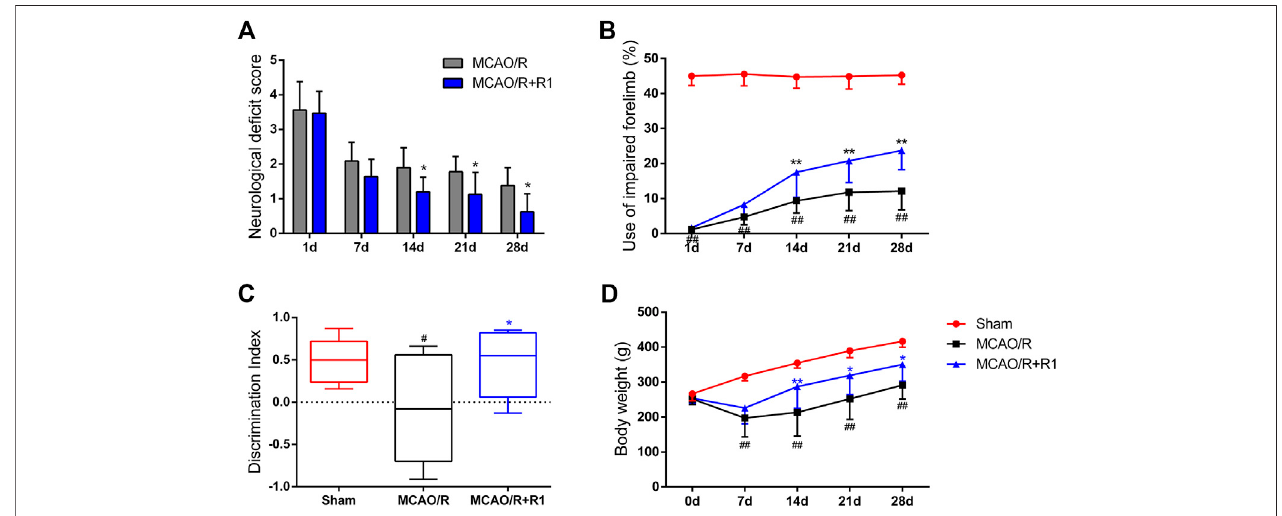
FIGURE 3| R1 restores long-term neurologicalfunction in rats subjected toMCAO. The behavioral tests were conducted on days 1, 7, 14, 21and 28 after MCAO surgery (A) Zea-Longa score (B) cylinder tests (C) novel object recognition tests on day 28 after MCAO surgery (D) The body weight of the rats in each treatment group over28days.Dataareexpressedasthemean ± SDandwereanalyzedbyANOVA. # p < 0.05and ## p < 0.01vs.Shamgroup;* p < 0.05and** p < 0.01vs.MCAO/Rgroup.